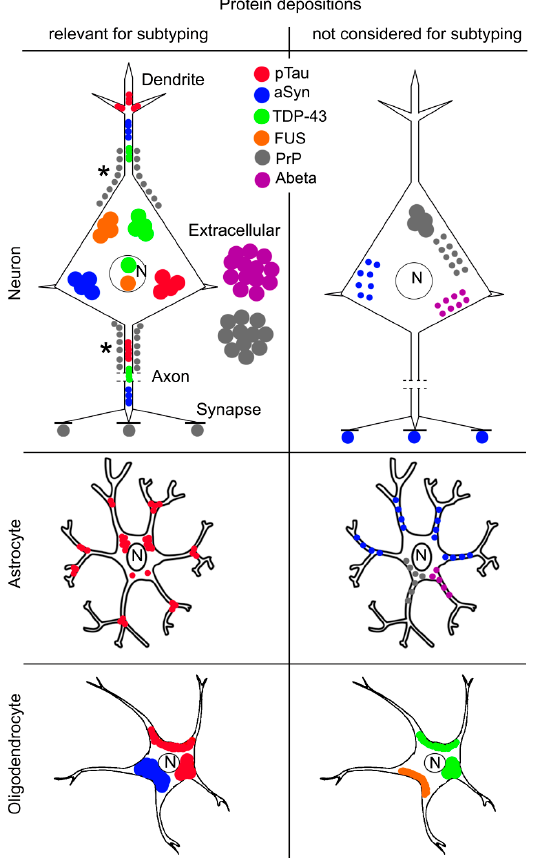
Figure 2. Overview of cellular vulnerability in the most frequent neurodegenerative proteinopathies. N: nucleus. Asterisk (*) for PrP indicates periaxonal or perineuronal. Since the drawing of the full extent of an axon would be out of the image the lines (---) in the axons indicate discontinuation (at the middle segment of the axon) of the drawing. Synapses are indicated by short black and bold lines (-).